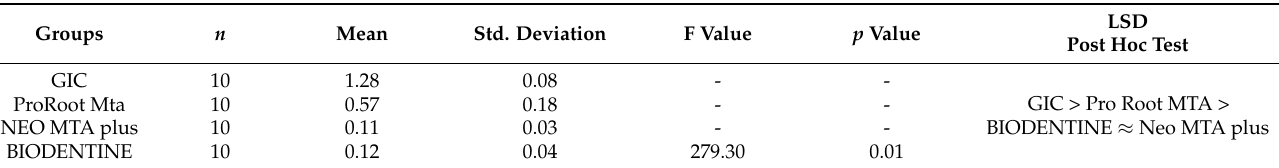
Table 3. Post hoc analysis to demonstrate differences between the sealing activity of different root end sealing materials after one month ( n — total number of samples).